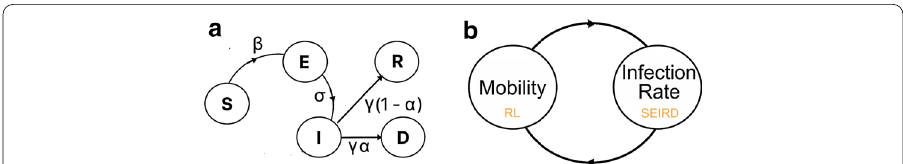
Fig. 1 System model: a state transitions in the susceptible, exposed, infected, recovered, death (SEIRD) model with the associated parameters; b a closed loop of reinforcement learning and SEIRD that controls human contact and infection of a